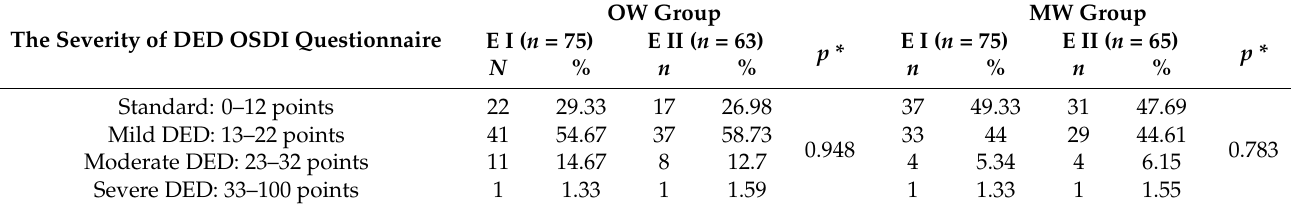
Table 7. Comparison of the results of the OSDI questionnaire in both groups at the beginning of the study and after 1 year.